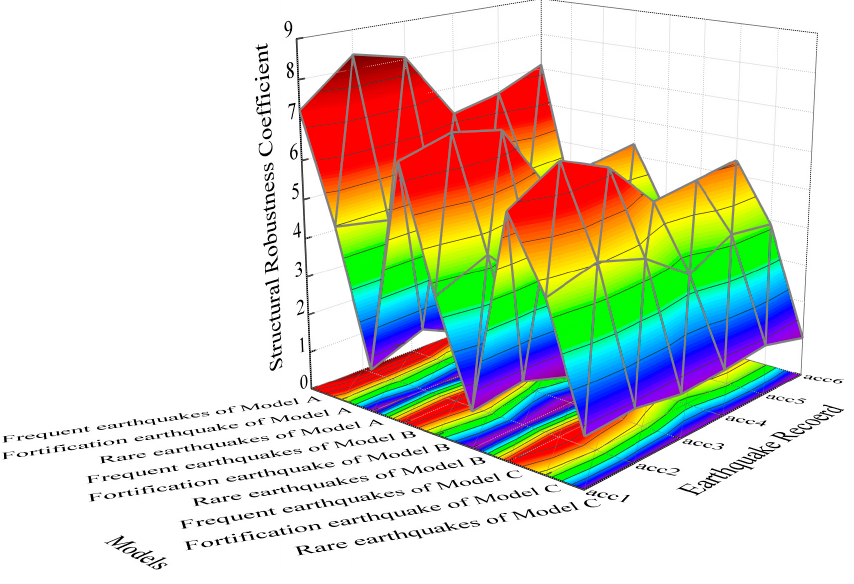
Figure 12. Curves of structural robustness coefficient.